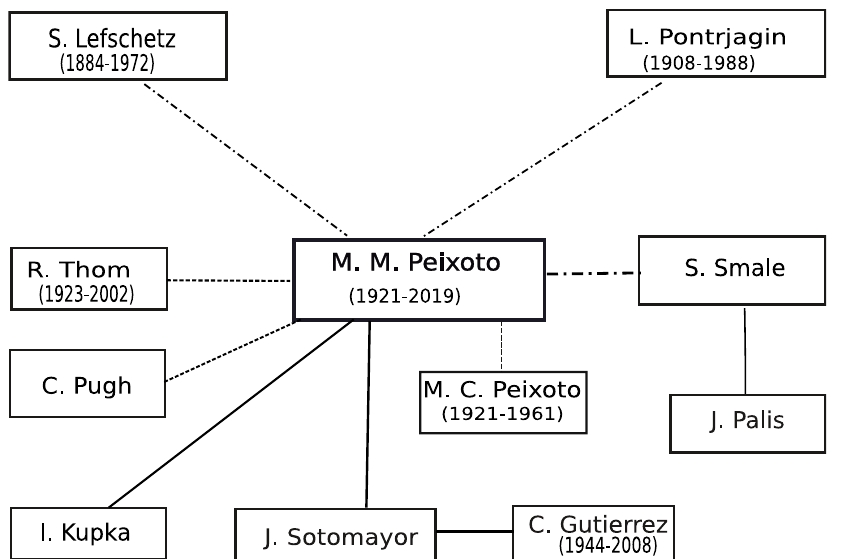
Figure 1. Mathematical contacts and